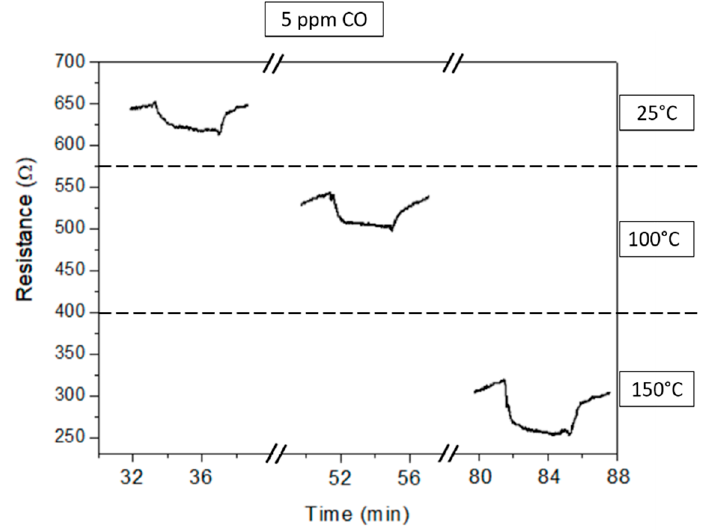
Figure 4. Transient response of the indium oxide sensor to 5 ppm CO at different operating temperatures.